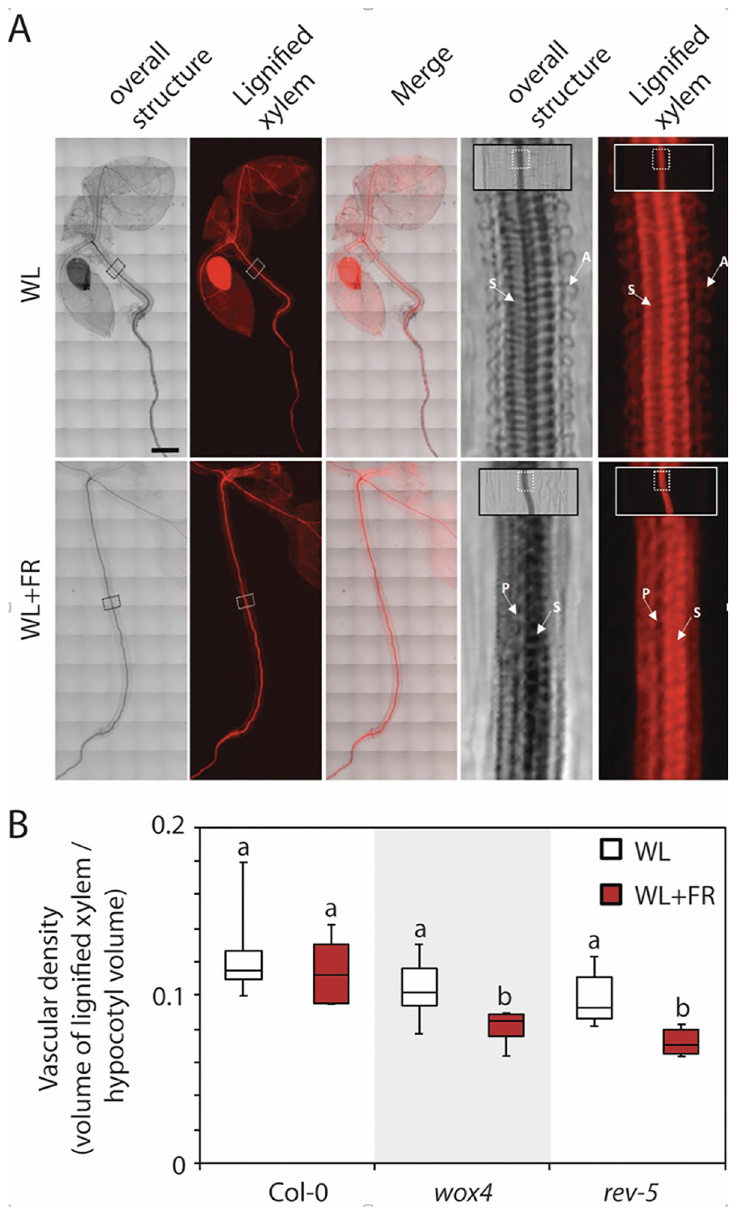
Fig 4. Virtual sections of white light and shade grown plants. A , Whole seedling tomography experiment with Col-0 wild type plants. Square boxes in the whole seedling images are enlarged to the right to highlight the organization of the vascular system. Arrows indicate tracheary elements with different secondary cell wall patterning: A for annular, S for spiral and P for pitted. Scale bar = 250 μ m. B , Measurements of the vascular density defined by the volume of the lignified xylem divided by the hypocotyl volume. (n = 6 seedlings per genotype).